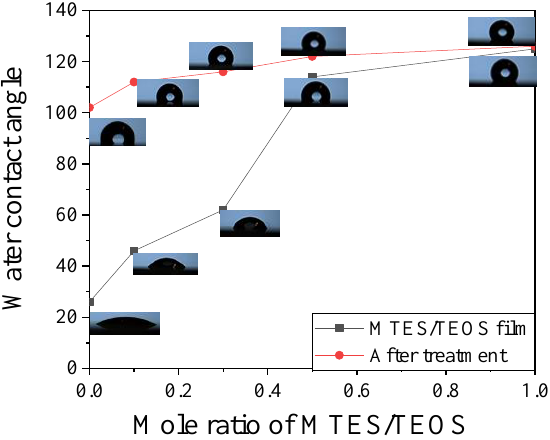
Figure 5. The water contact angle (WCA) of untreated film and the film after treatment.